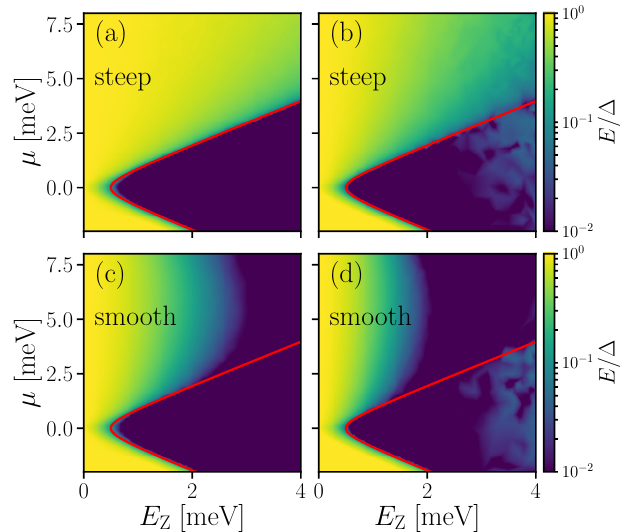
Figure 3: Phase diagram as a function of E and µ of the device sketched in Z Fig. 2(a), for (a) α = 100meV nm, σ = 10 nm, (b) α = 40meV nm, σ = 10 nm, (c) α = 100meV nm, σ = 200 nm, and (d) α = 40meV nm, σ = 200 nm. The red line = (cid:112) ∆ 2 + µ 2 . The color indicates the indicates the topological phase boundary E Z lowest energy of the Hamiltonian in units of ∆ on a logarithmic scale. The potential barrier height is V = 10